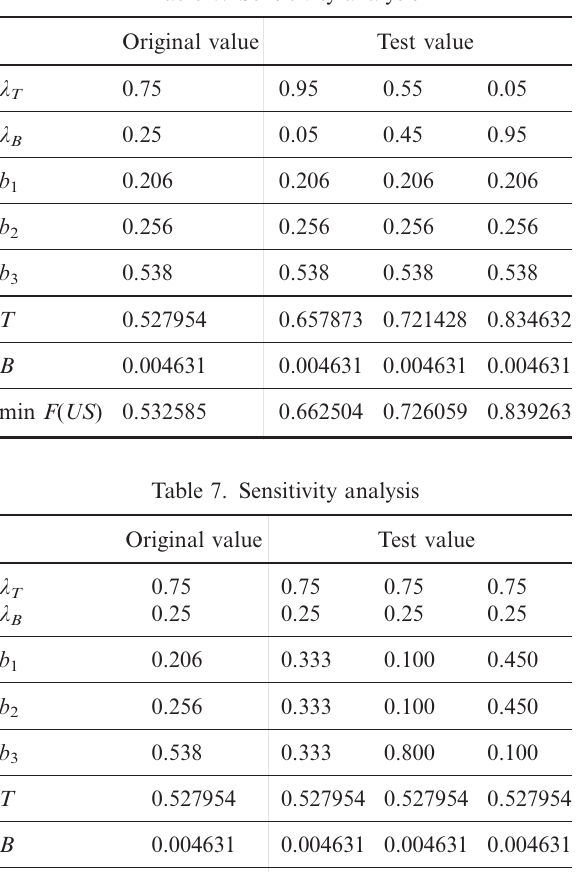
Table 6. Sensitivity